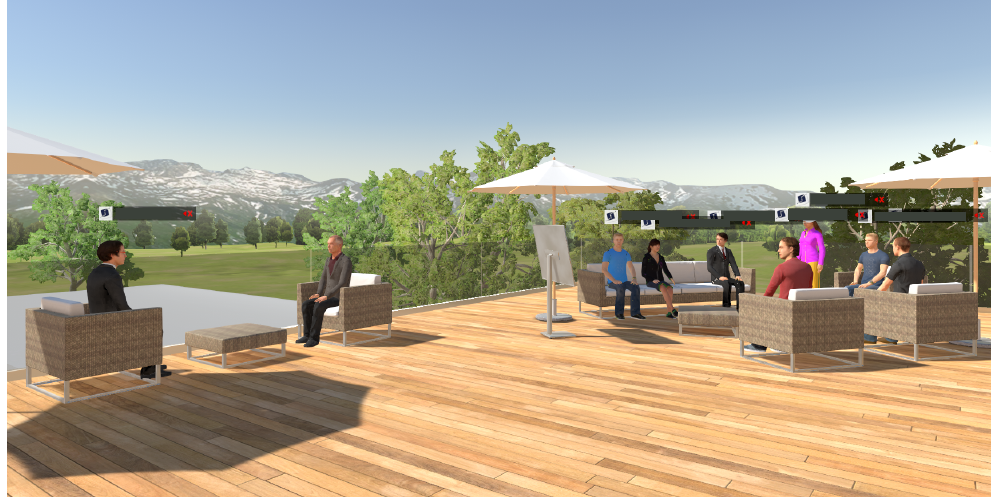
Figure 12. Leisure time in the terrace outside the e-CLOSE building in